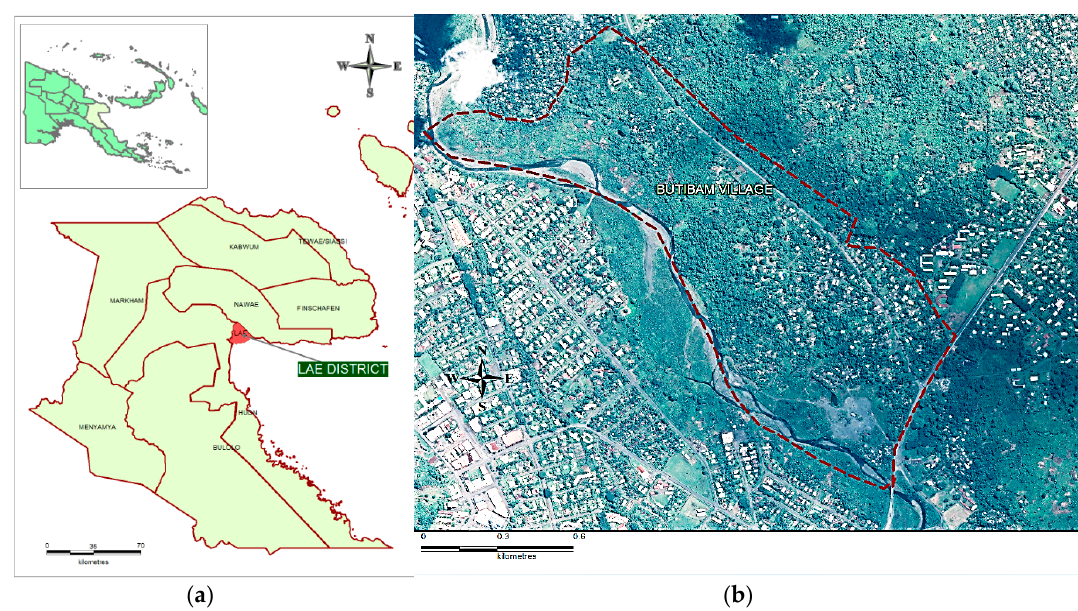
Figure 4. ( a ) Map of Lae District in Morobe Province ( b ) Study Area Delineated with Dotted Red Lines.